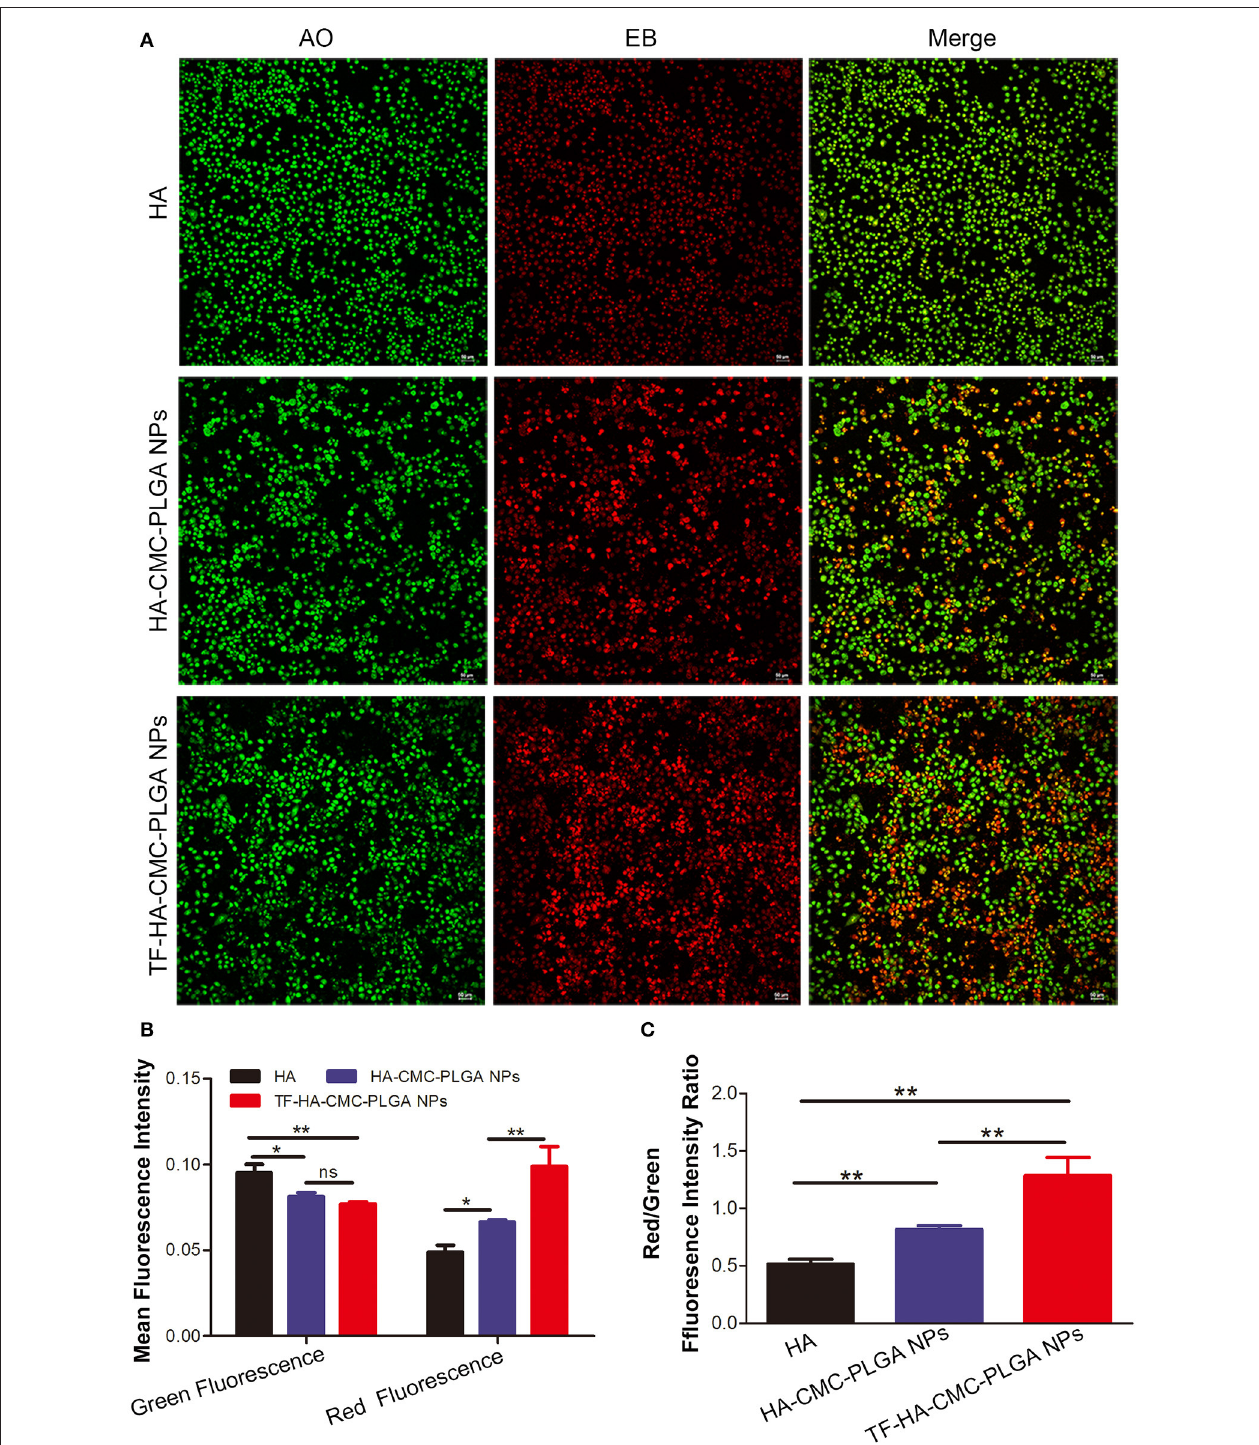
FIGURE 7 | (A) Detection of apoptosis level by AO/EB dual staining on A549 cells, which incubated with HA, HA-CMC-PLGA NPs, and TF-HA-CMC-PLGA NPs (equivalent to 0.05 µ M HA) for 12h after light irradiation (470nm, 90 mW/cm 2 , 15min). (B) Green fluorescence and red fluorescence intensity assay in A549 cell incubated with HA, HA-CMC-PLGA NPs, and TF-HA-CMC-PLGA NPs by using Image J software. (C) Red/Green fluorescence ratio in A549 cells incubated with HA, HA-CMC-PLGA NPs, and TF-HA-CMC-PLGA NPs. * p < 0.05; ** p < 0.01; ns p > 0.05. Scale bar = 50 µ m.